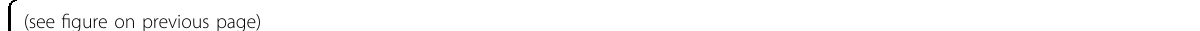
Fig. 2 Immunological features of CD4 + T subsets across the three conditions. a Condition preference of each cluster. Y -axis: average percent of samples across the three conditions. Conditions are shown in different colors. Each bar plot represents one cell cluster. Error bars represent ±S.E.M. for 4 healthy donors and 14 chronic HIV-1-infected individuals. * P < 0.05; ** P < 0.01; two-sided unpaired Mann – Whitney U -test. b Box plots of the cytotoxicity and exhaustion scores across different clusters and conditions. Conditions are shown in different colors. Horizontal lines represent median values, with whiskers extending to the farthest data point within a maximum of 1.5× interquartile range. * P < 0.01; ** P < 0.001; *** P < 0.0001; two-sided unpaired Dunn ’ s (Bonferroni) test. c DEGs of CD4 + T cells from the TPs or ARTs in comparison with those from the HDs. Each red dot denotes an individual gene with Benjamini – Hochberg adjusted P value (two-sided unpaired Mann – Whitney U -test) ≤ 0.01 and average log 2 (fold change) ≥ 0.5 for the TP/HD and ART/HD comparisons. Example genes are labeled with the gene name. d Gene enrichment analyses of the DEGs in TPs compared with healthy donors. GO terms are labeled with name and id and sorted by − log10 ( P ) value. A darker color indicates a smaller P value. The top 20 enriched GO terms are shown. Interesting terms are labeled in red color. e Similar to b but for in fl ammation and IFN- α response score. f Dot plot showing expression of some genes associated with in fl ammation and IFN- α response processes across the three conditions. The size of the circle indicates the percentage of cells expressing pathway-associated genes under each condition. The color of the circle represents the expression levels of pathway-associated genes under each condition, and the color red means a relatively high expression level, and black means a relatively low expression